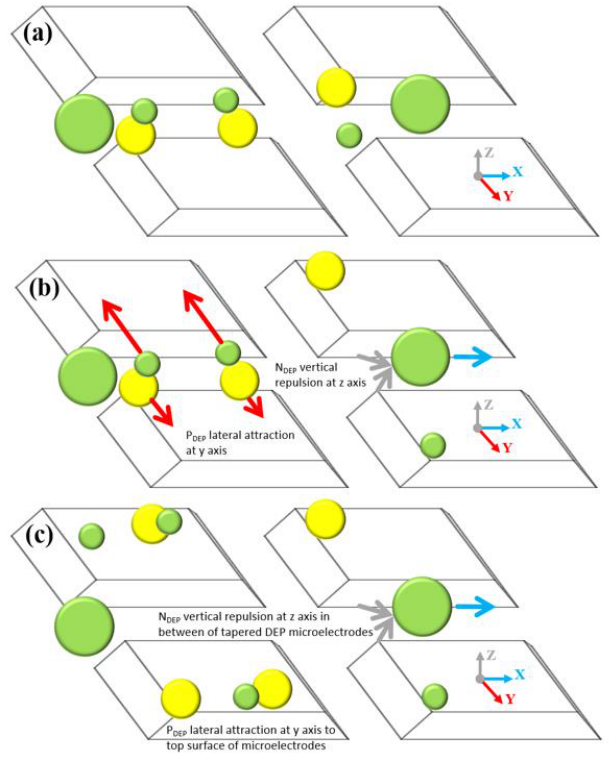
Figure 16. The tilt view sequence separation of 1 µ m, 3 µ m and 10 µ m Ps: ( a ) The position before the input frequency is applied, ( b ) the separation sequence and ( c ) the separation yield.